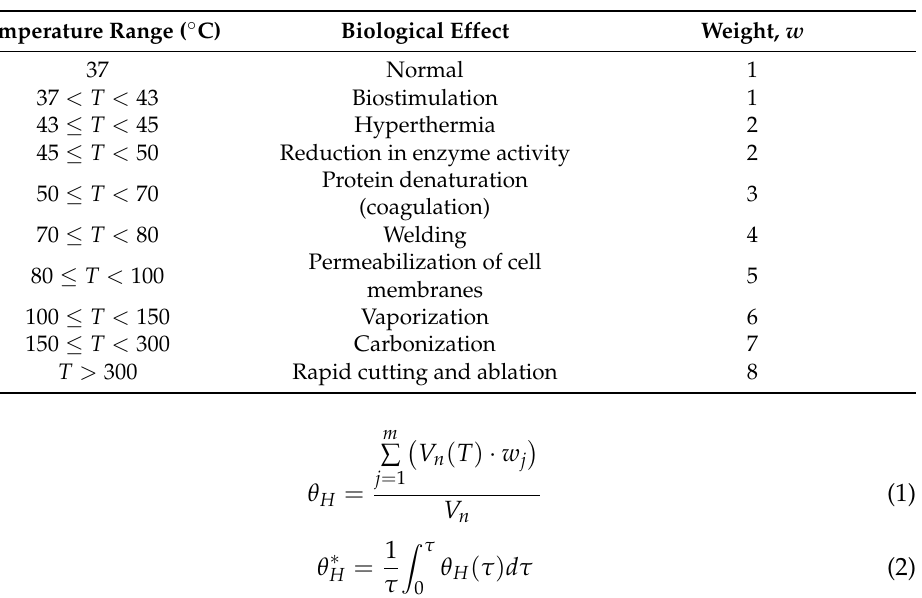
Table 1. Laser-induced thermal effects